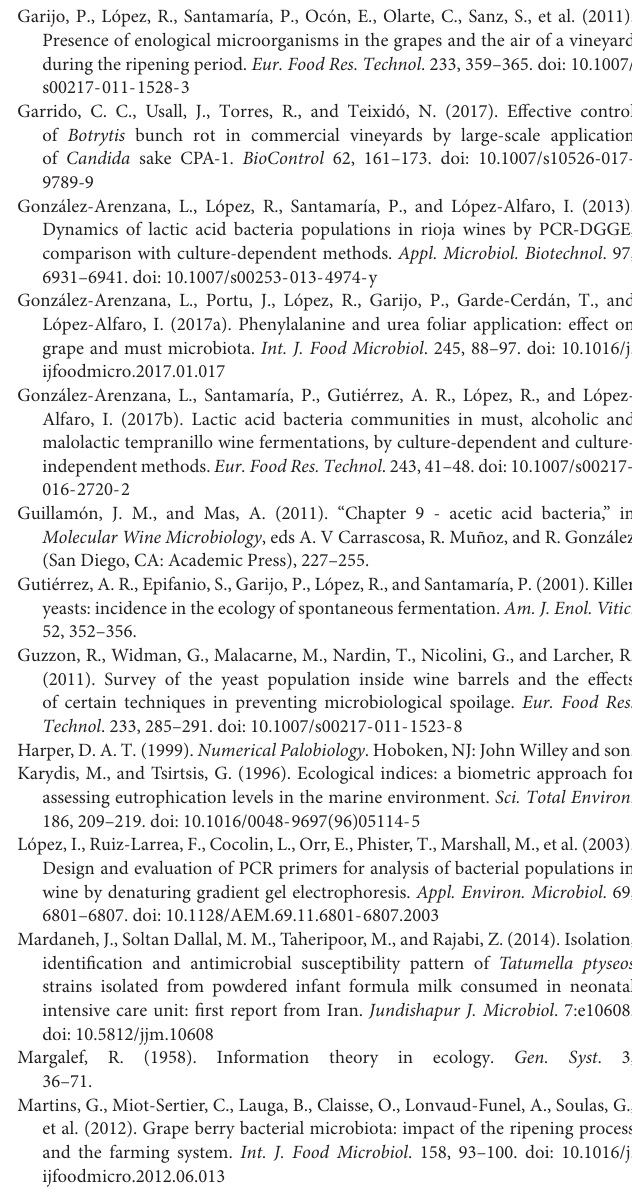
FIGURE S2 | Some of the WBAC 1-2 amplicons species detected by DGGE in control replicates (C1, C2, C3, and C4), in samples form biofungicide treatment (B1, B2, B3, and B4) and in samples from chemical fungicide treatment (Ch1, Ch2, Ch3, and Ch4).